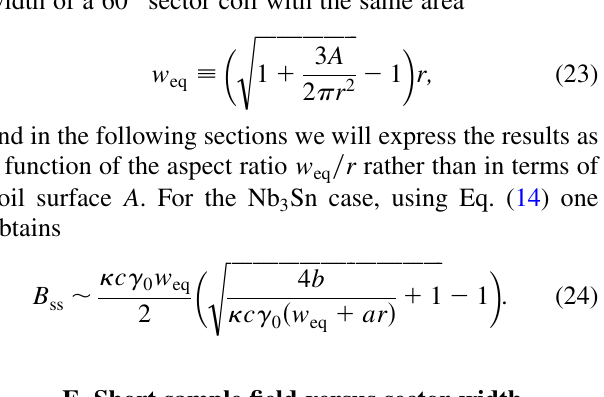
TABLE V. Ratio between the short sample field evaluated for Nb-Ti, different sector widths through Eq. (22) and B (cid:5) c 2